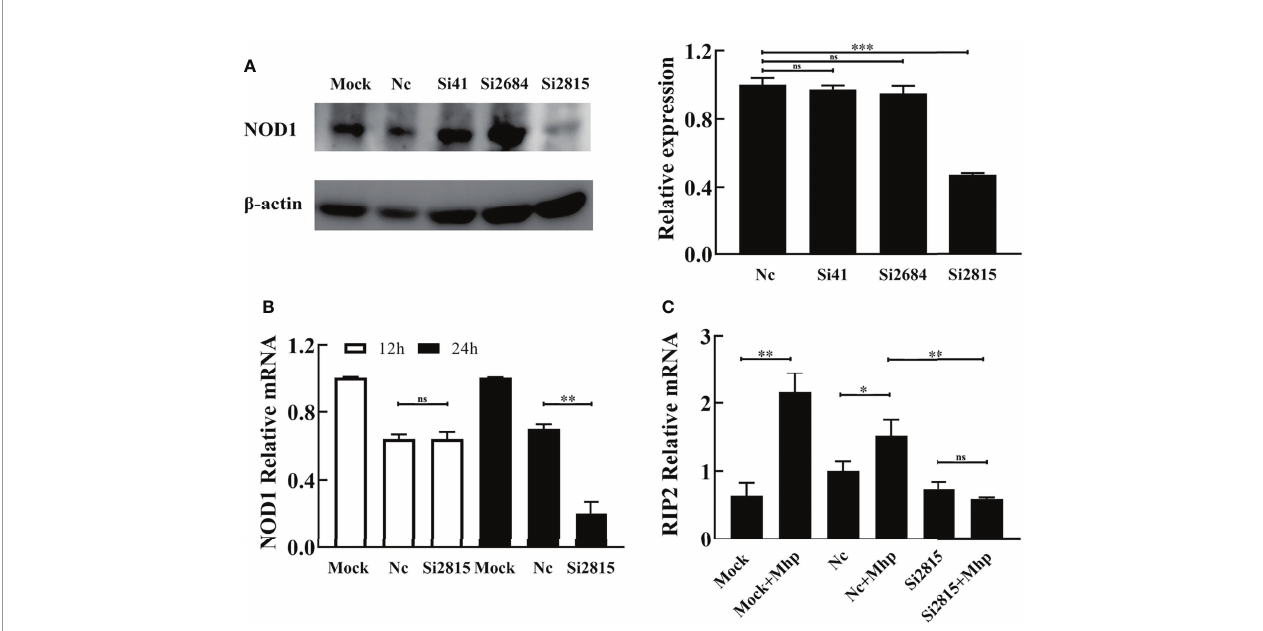
FIGURE 2 | Knockdown of NOD1 inhibits the activation of RIP2 signaling pathway by M. hyopneumoniae . (A) Silencing ef fi ciency of siRNA targeting NOD1. Alveolar macrophages were transfected with the indicated siRNA. The expression of NOD1 was evaluated by western blot at 24 h post transfection. Anti- b -actin was included as a control for sample loading. The relative levels of NOD1 in comparison to those in NC siRNA treated cells are shown as folds in the right panel. (B) The mRNA transcription of NOD1 was measured through real time RT-PCR and compared with that of GAPDH at 12 h/24 h post infection (hpi). (C) Alveolar macrophages were transfected with NOD1 siRNA or NC siRNA for 24 h, and then infected with M. hyopneumoniae (100 m L, 10 8 CCU). Cells were collected at 6 hpi, and subjected to real-time RT-PCR to determine the expression of RIP2 mRNA. * P < 0.05, ** P < 0.01, and *** P < 0.001 indicate statistically signi fi cant differences among different groups, and ns represents no